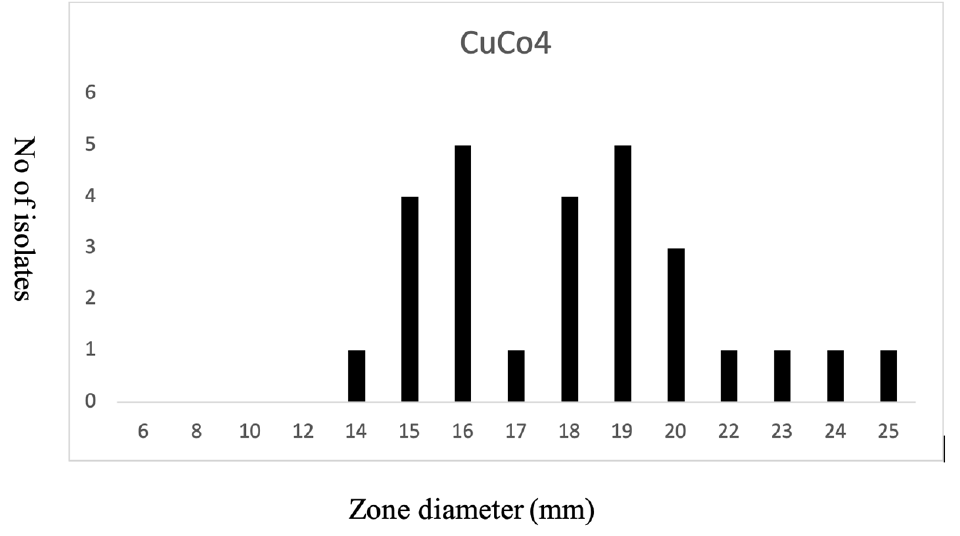
Figure 3. Susceptibility profile of S. epidermidis to copper. Disc diffusion inhibition zones were defined for 24 S. epidermidis isolates when exposed to 10 μ L of 1M stock (1 μ g/ μ L) of copper sulfate (CuSo4).